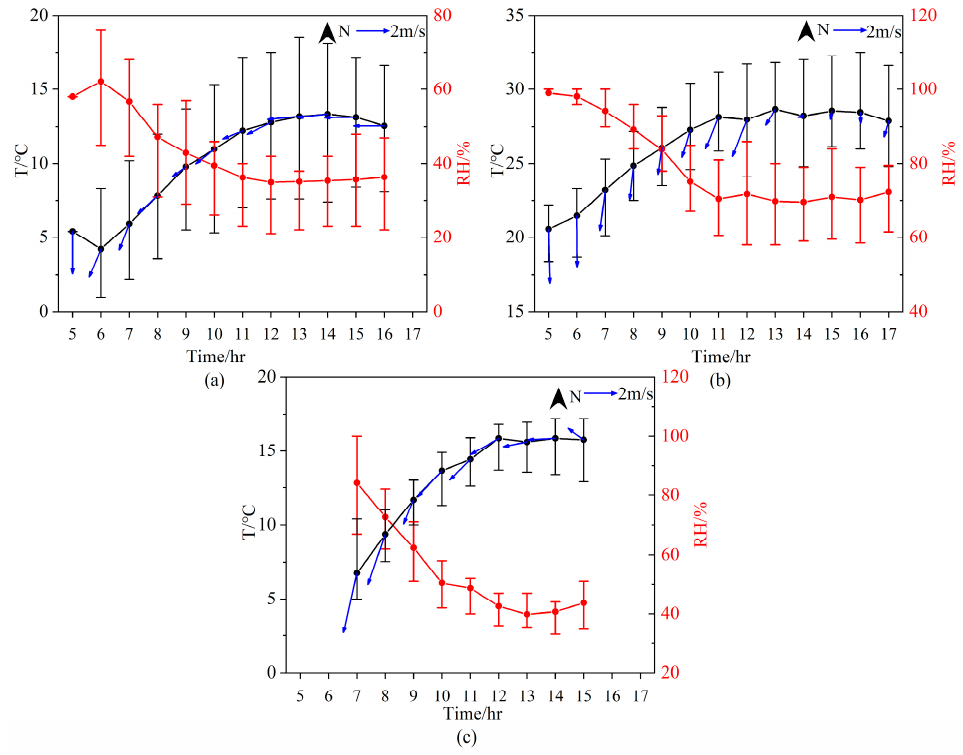
Figure 8. Diurnal variations of temperature (black), relative humidity (red), wind speed and direction (blue) in ( a ) April, ( b ) July and ( c ) October